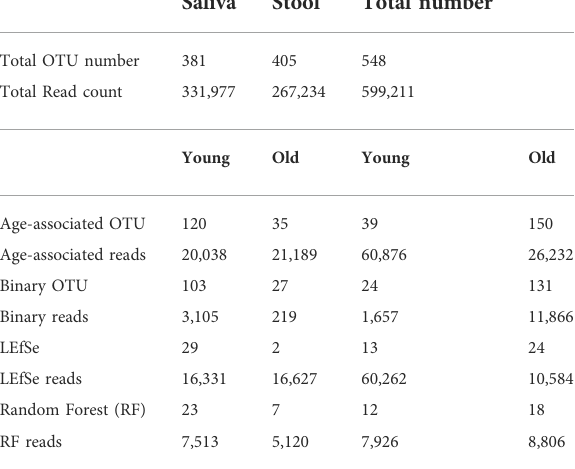
TABLE 2 Summary of OTU selected by each